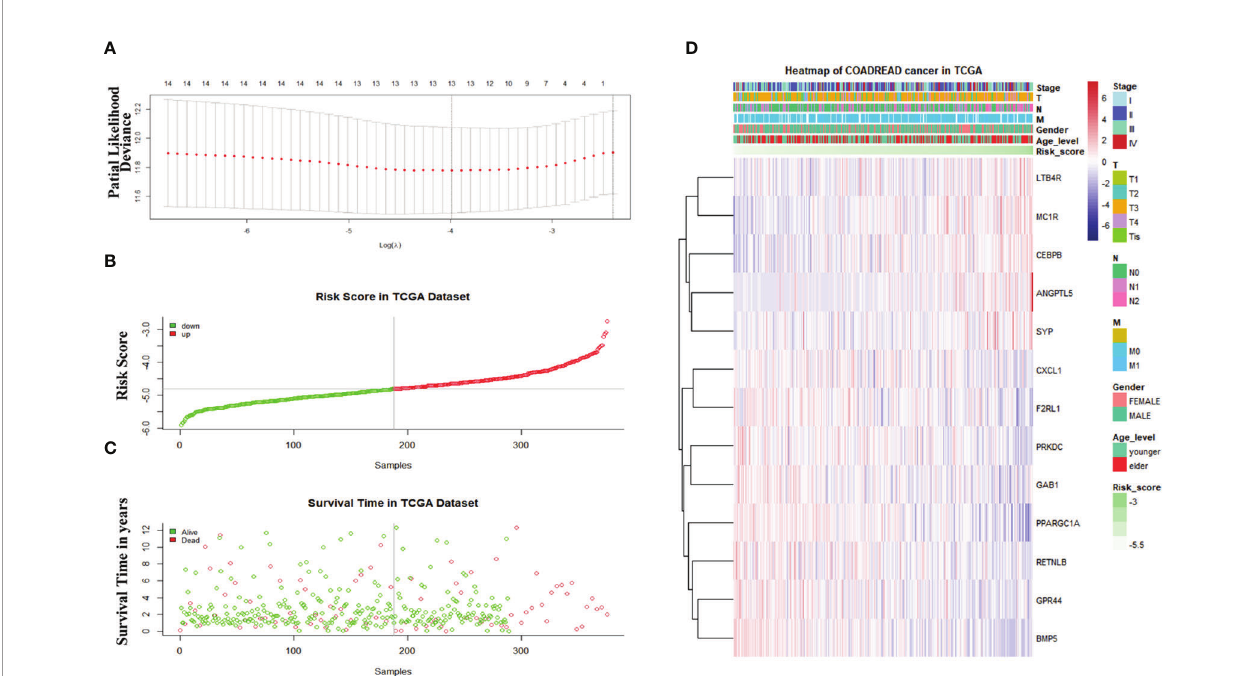
FIGURE 6 | Construction of the immune-related gene-derived prognostic classi fi er. (A) Determination of the number of factors via least absolute shrinkage and selection operator analysis. (B) The survival duration and status of patients. (C) The distribution of risk score. (D) A heatmap of immune-related genes and the pro fi le of each clinical feature in the classi fi